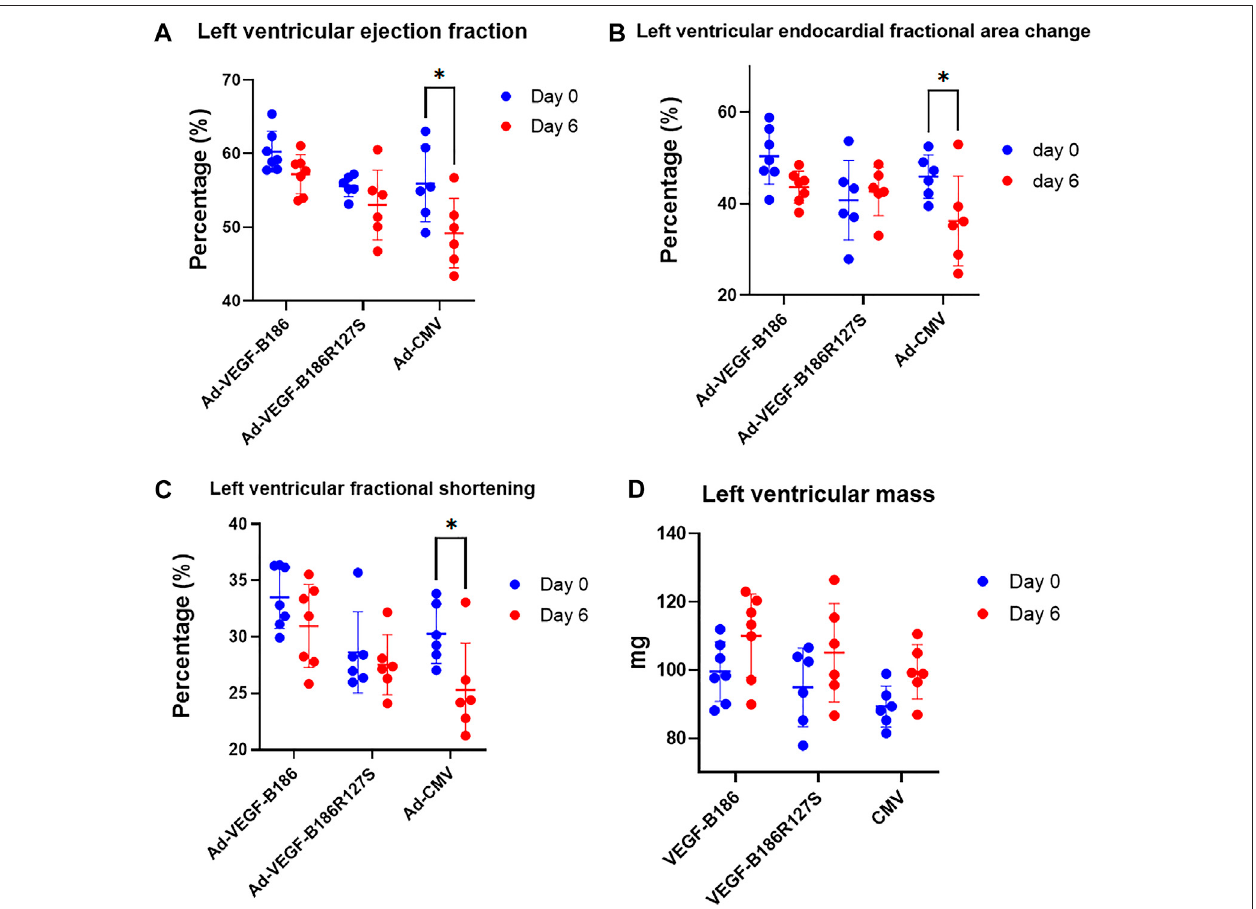
FIGURE 9 | Cardiac function analysis. Analysis of left ventricular (A) ejection fraction, (B) fractional area change, (C) fractional shortening, and (D) left ventricular mass. Each dot indicates one mouse; n = 7 in Ad-VEGF-B186, n = 6 in Ad-VEGF-B186R127S, and n = 6 in Ad-CMV groups. Horizontal bars indicate mean ± SD and p values vs. each group by two-way ANOVA, followed by Sidak ’ s multiple comparison